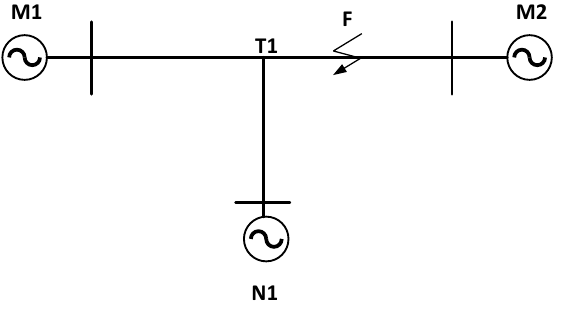
Figure 4. T transmission